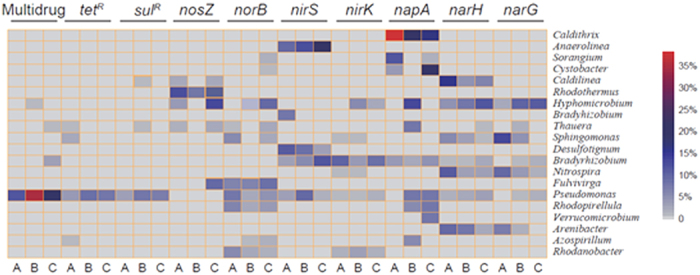
The selected denitrification functional genes were BLAST against the NCBI-nr database for taxonomic assignment (top 20 genera; gene hosts) with an e-value threshold of 10−5.For the reads of the 3 types of resistance genes, their taxonomic assignments were determined using BLAST against NCBI-nr, and the relative abundance of those assigned to the top 20 genera are also shown. The reads number visualized by MEGAN was taken as 100%. The A, B and C denote the mean values of two replicates of previously unexposed (raw refuse for short-term exposure), SMT- and OTC-exposed groups, respectively; and the color intensity in each panel shows the percentage of each target gene carrying a genus in one sample.